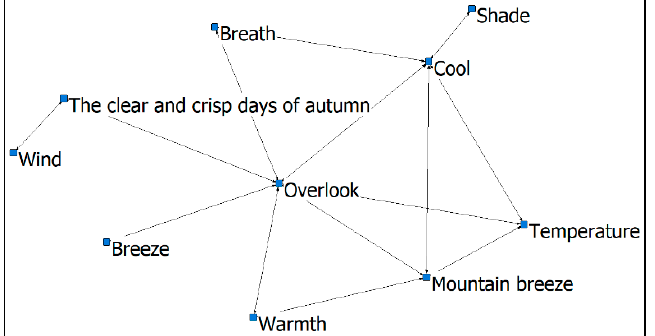
Figure 10. 2-1. Urban forest park elements based on audio-visual interactive perception.